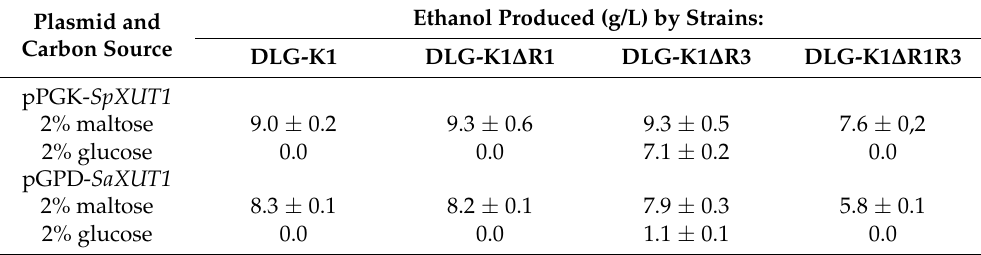
Table 3. Ethanol production under microaerobic conditions by strains expressing the SpXUT1 or SaXUT1 permeases, determined at the end of growth on O-YNB medium containing the indicated carbon sources in a microplate reader at 30 °C.